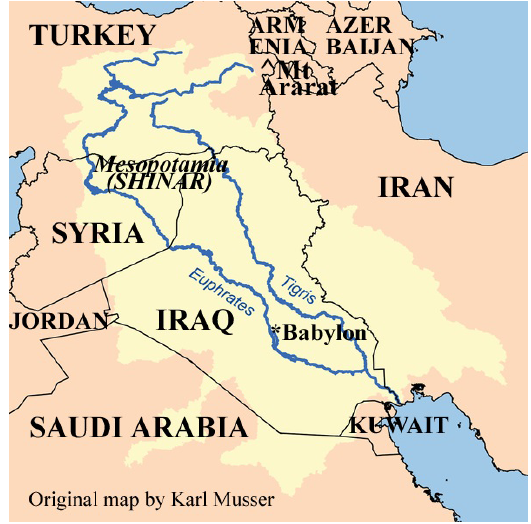
Figure 1. The Euphrates-Tigris Rivers basin (created by Karl